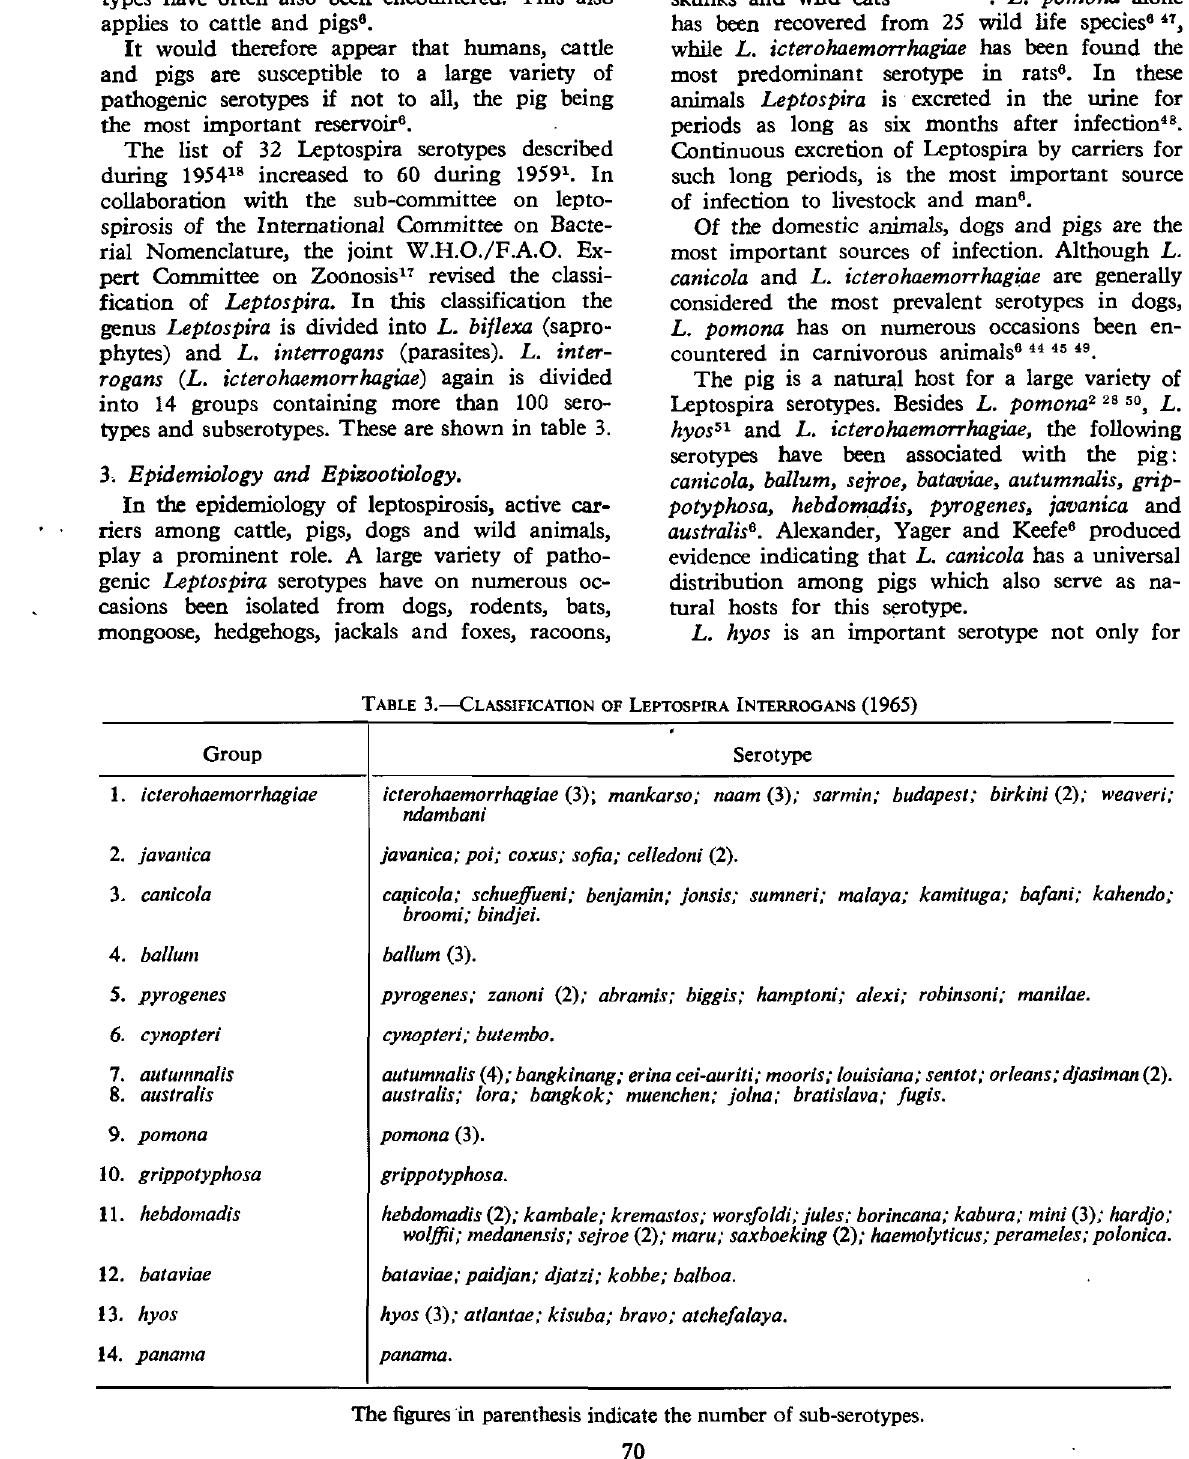
TABLE 3.-CLASSIFICATION OF LEPTOSPIRA INTERROGANS